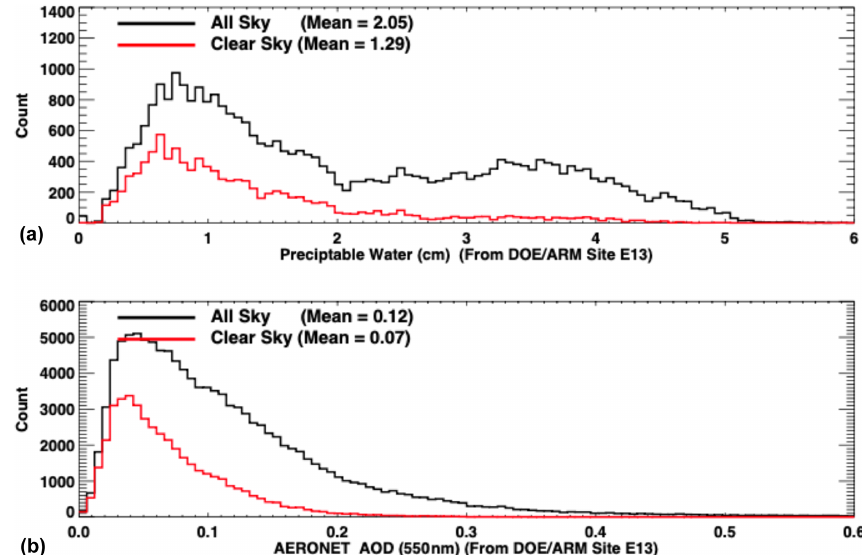
Figure 9. (a) The 15min mean precipitable water distributions from microwave radiometer observations at the Atmospheric Radiation Measurement (ARM) Southern Great Plains (SGP) E13 site under all-sky and clear-sky conditions. (b) The 15min mean AOD distributions from AERONET sun photometer measurements at 550nm. “Clear sky” is defined here as a 15min time period where the surface radiometry- based cloud fraction, from the Long et al. (2006) methodology, equals zero.